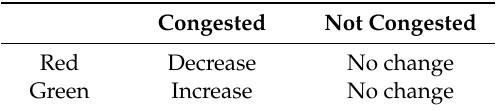
Table 2. Rules applied to adjust the traffic light duration time .